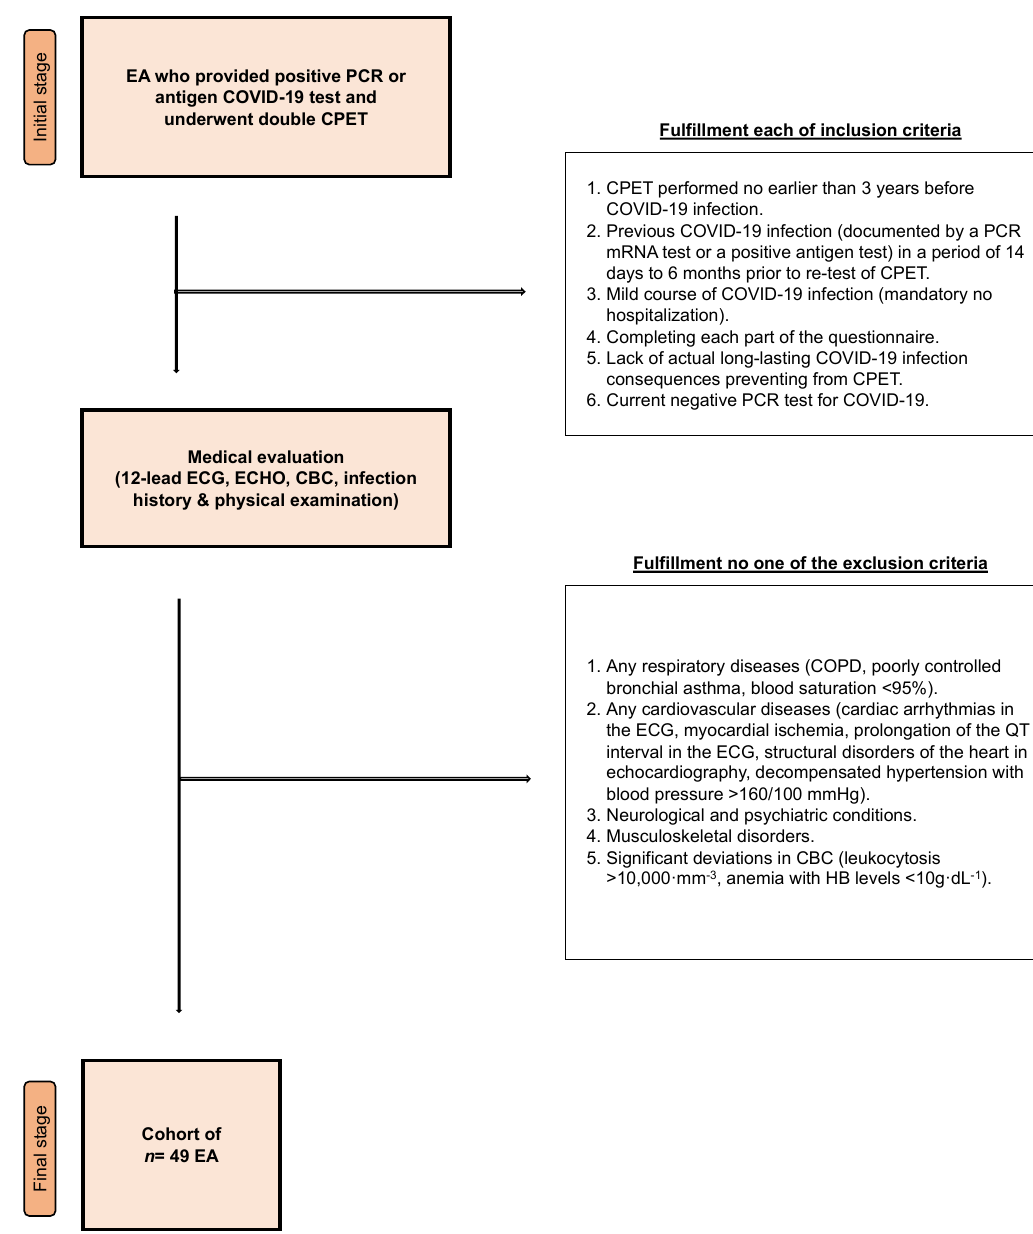
Figure 1. Recruitment procedure. Abbreviations: EA—endurance athlete; PCR—polymerase chain reaction; COVID-19—Coronavirus disease 2019; CPET—cardiopulmonary exercise test; ECG—12-lead electrocardiogram; ECHO—echocardiography examination; CBC—complete blood count; COPD—chronic obstructive pulmonary disease; HB, blood hemoglobin.